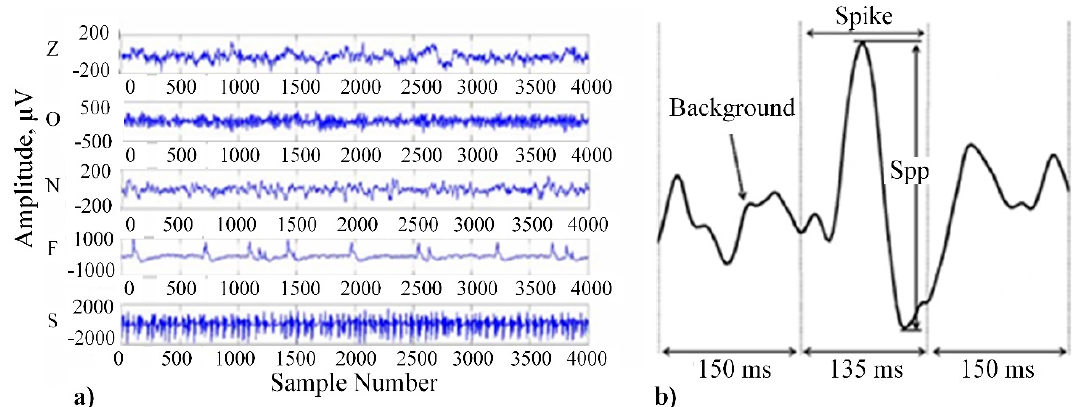
Figure 3. EEG signal: ( a ) example of raw data [43]; ( b ) peak to peak signal amplitude evaluation technique [44].